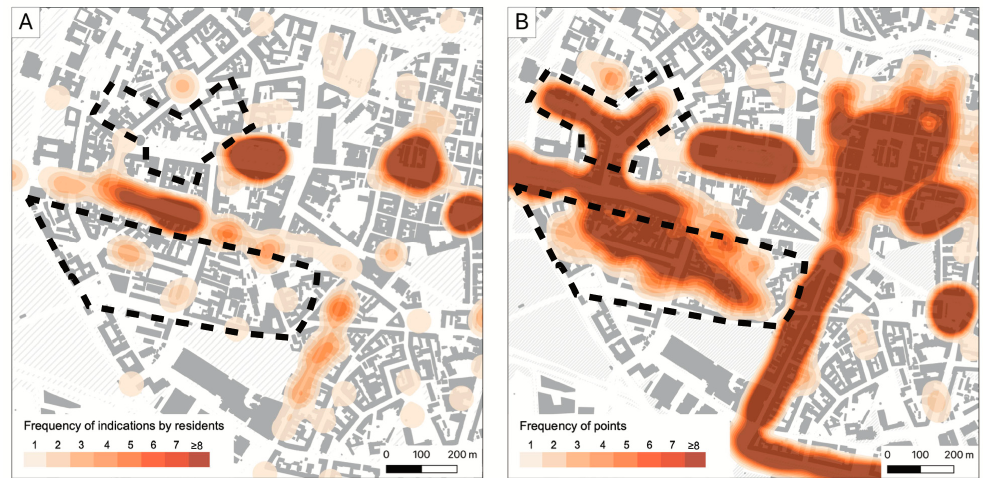
Figure 5. Comparison of places indicated by the group of residents ( A ) and urban planners ( B ) regarding areas of lack of thermal comfort—areas of downtown residential buildings. The dashed black lines mark the areas of difference. Source of reference data: © OpenStreetMap contributors, see: https://www.openstreetmap.org/copyright (accessed 10 February 2023).